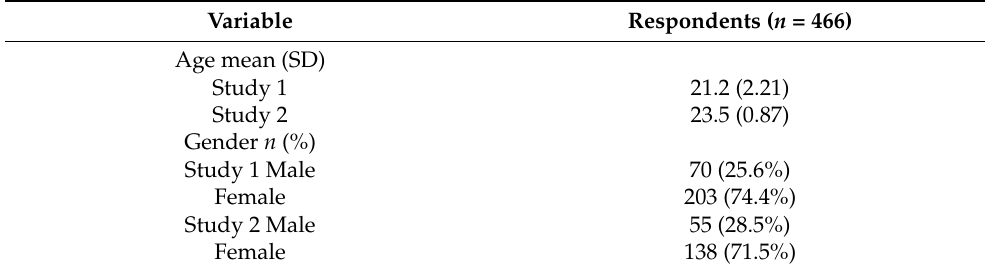
Table 1. Participant demographic